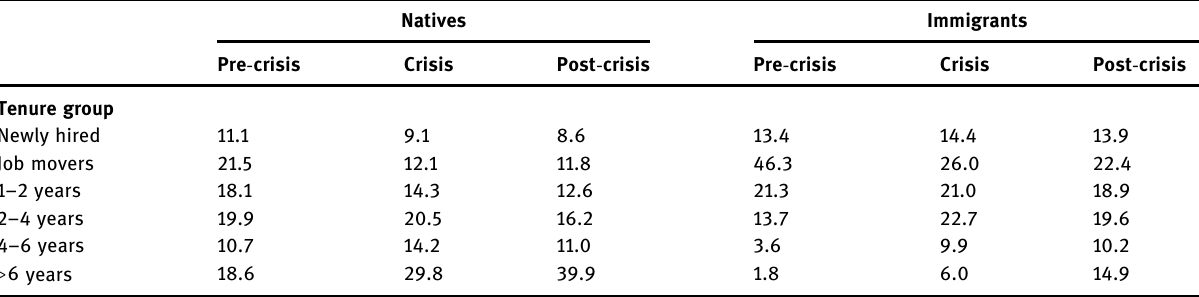
Table 5: Job tenure categories by nationality